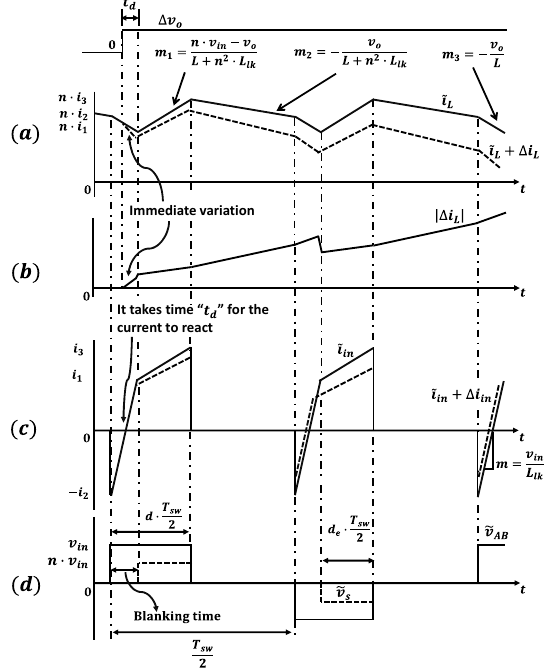
Figure 10. Dynamic response to an output voltage step change. ( a ) Output inductor current, ( b ) incremental component of output inductor current, ( c ) input current and ( d ) primary and secondary voltage.